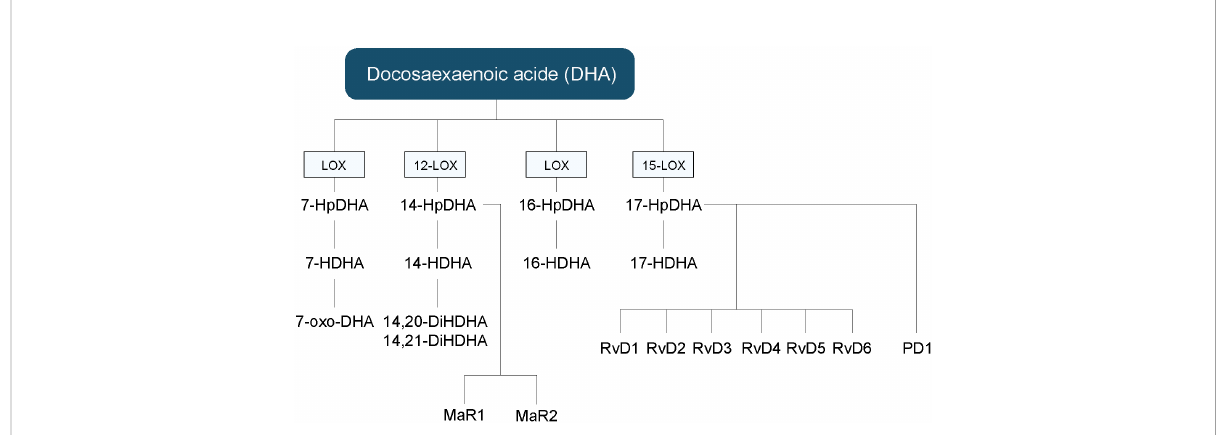
FIGURE 4 Hydroxy fatty acids, and other lipid mediators ’ biosynthetic pathways derived from DHA. DHA, docosahexaenoic acid; HDHA, hydroxy-docosahexaenoic acid; HpDHA, hydroxy-peroxy-docosahexaenoic acid; MaR, maresin; oxo-DHA, oxo-octadecatrienoic; PD, protectin; Rv,